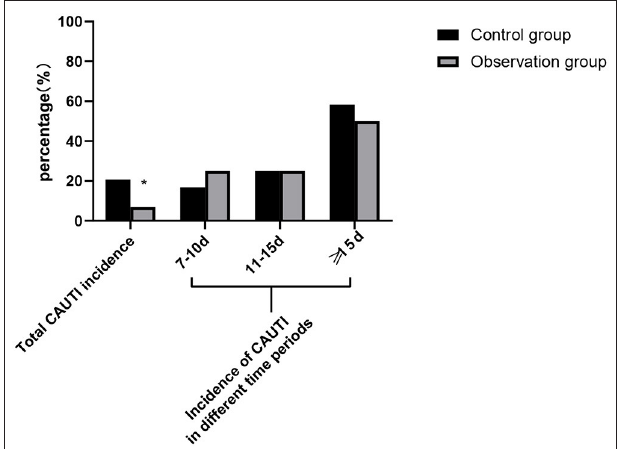
FIGURE 1 | Comparison of total catheter-associated urinary tract infection (CAUTI) incidence between the two groups and CAUTI incidence in different time periods. Compared with the control group, * p < 0.05.